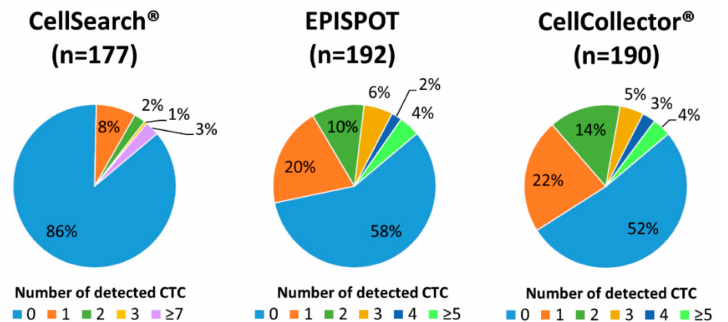
Figure 1. Distribution of detected circulating tumor cells (CTC) using the CellSearch ® system, dual fluoro-EPISPOT assay, and CellCollector ® . The results of CTC quantification in all samples (i.e., samples collected one day before and at least three months after radiotherapy) tested with the indicated assay.